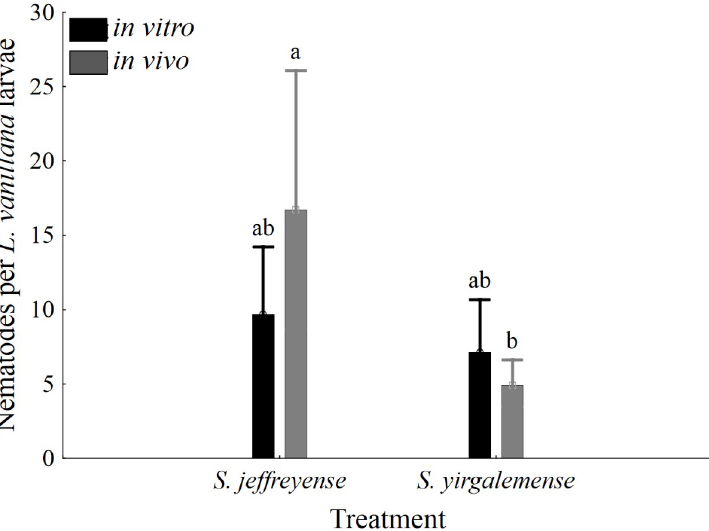
Fig 5. Average number of nematodes found within cadavers of Lobesia vanillana larvae. Cadavers were rinsed and dissected following susceptibility bioassays, and the number of infective juveniles found within each cadaver was recorded. Different letters on the bars denote statistical significance (p < 0.05), calculated using Bootstrap.